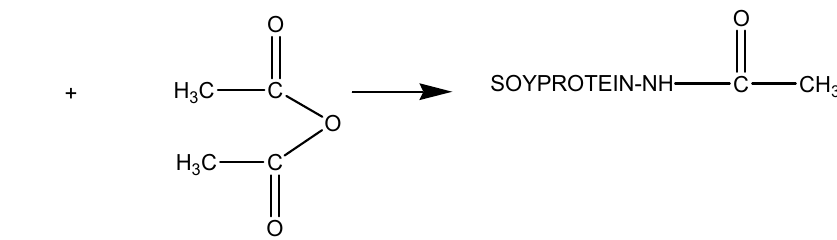
Figure 19. Acylation of an amino group of soy protein. Adapted from [79], with permission from Elsevier and Copyright Clearance Center, 2002.